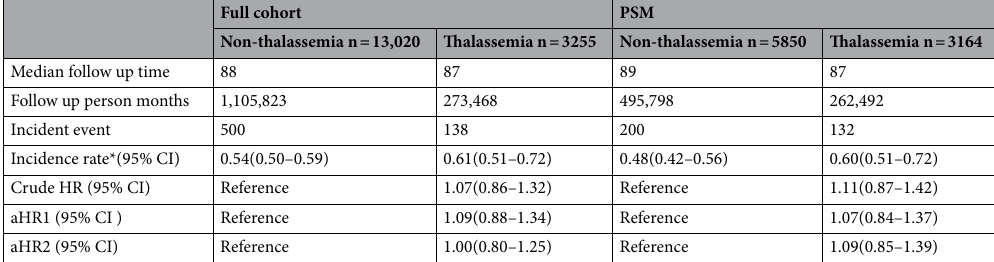
After adjustment of demographic variables and comorbidities, the aHR was 1.00 (95% CI 0.80 to 1.25). After PSM, the crude HR of gout arthritis in the thalassemia group was 1.11 (95% CI 0.87 to 1.42) compared with the control group. After adjustment of demographic data, the aHR of gout arthritis in the thalassemia group was 1.07 (95% CI 0.84 to 1.37) compared with the non-thalassemia group. After adjustment of demographic variables and comorbidities, the aHR was 1.09 (95% CI 0.85 to 1.39). The Kaplan–Meier curve showed that the cumulative incidence of gout arthritis was not a significant difference in the thalassemia group than in the comparison group